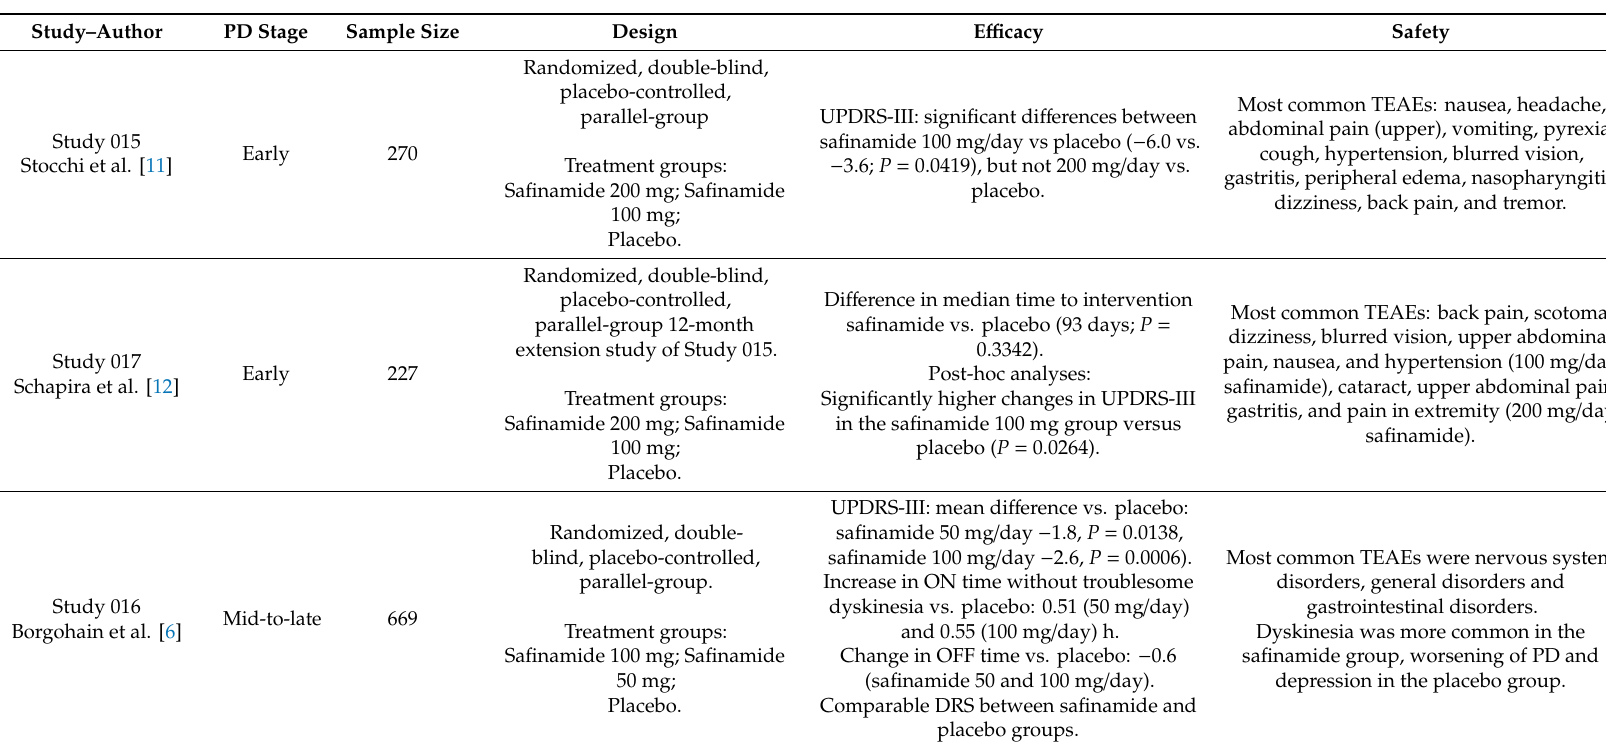
Table 1. Main e ffi cacy and safety outcomes reported in pivotal trials of safinamide in Parkinson’s